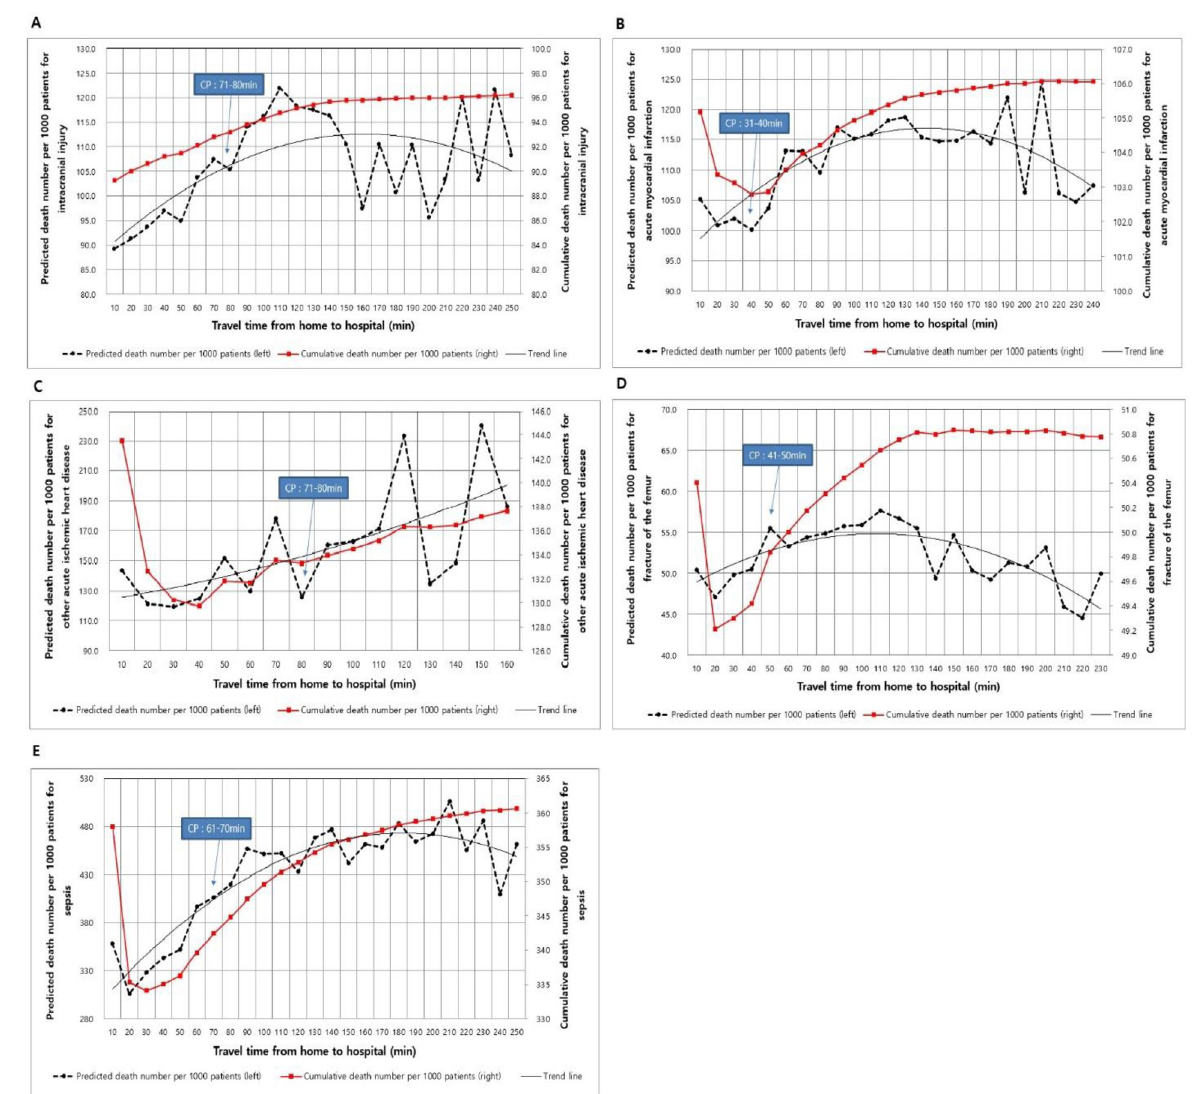
Table 4). The difference in mortality risk was the largest among patients with other acute